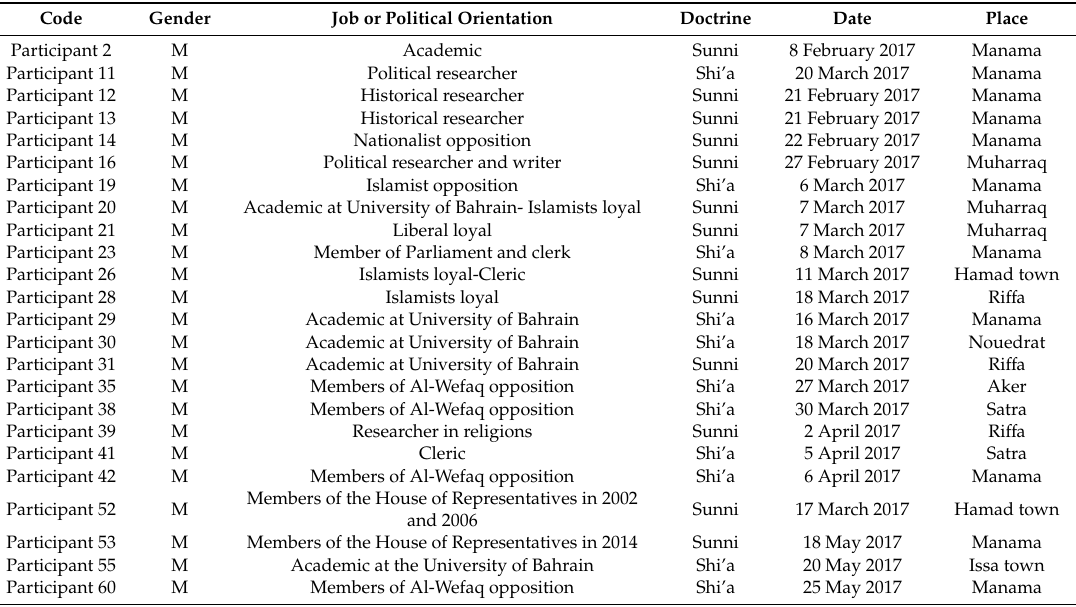
Table A1. Interviewee